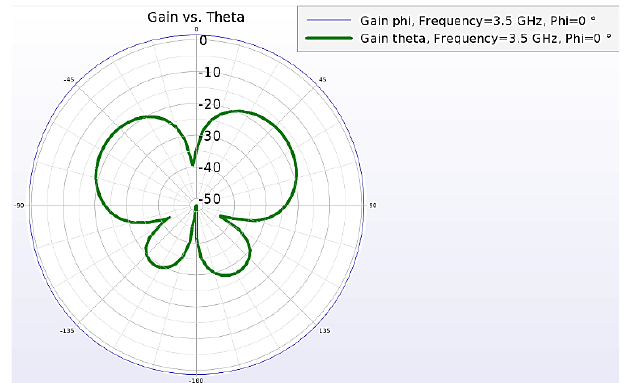
FIGURE 6. Simulated Gain Plots for 3.5 GHz